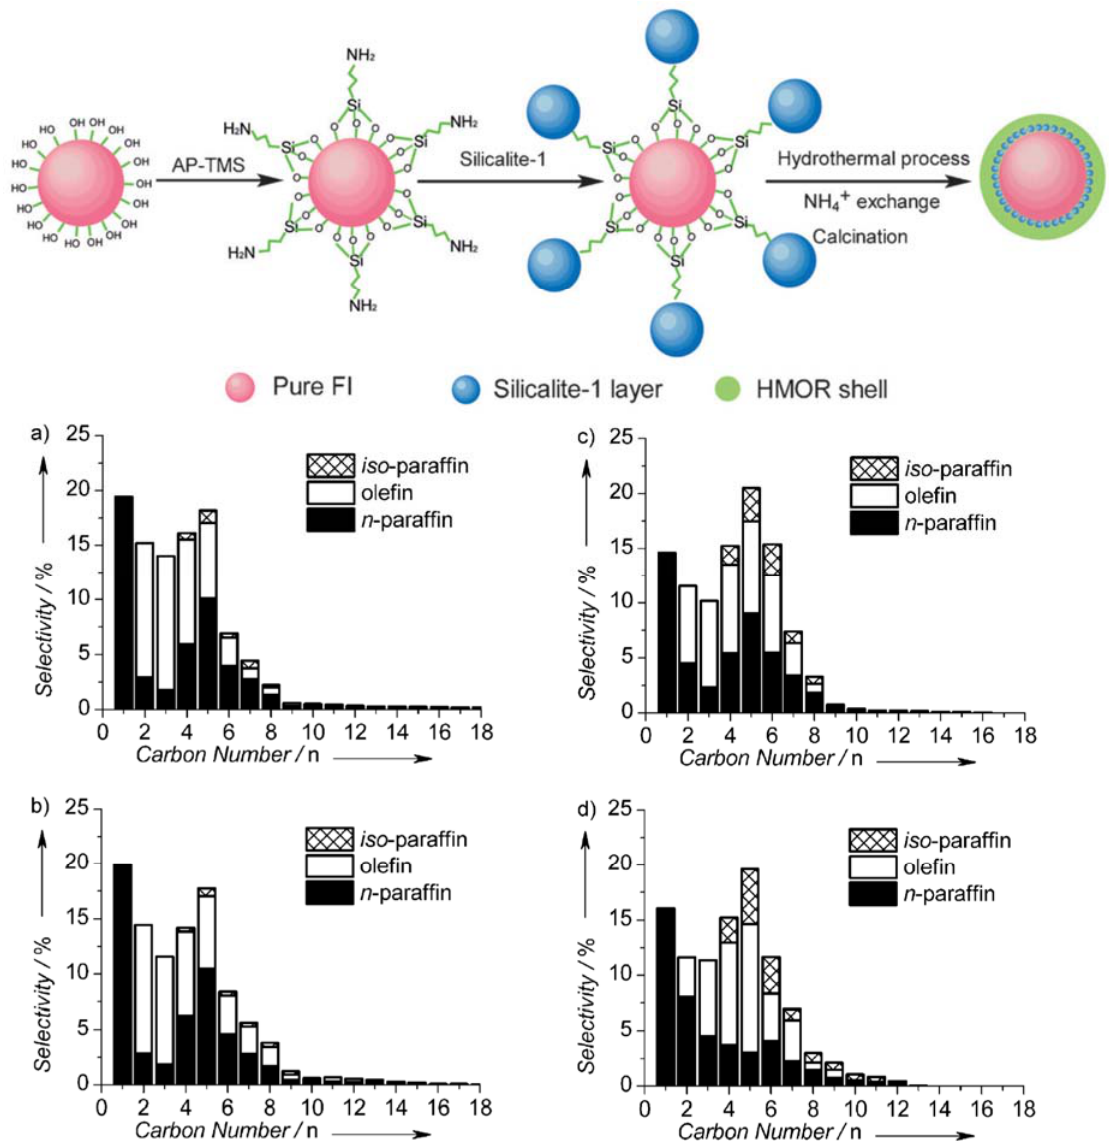
Figure 13. Scheme of the synthesis procedure of HMOR/FI capsule catalysts (FI = Fused Iron) without template and product distributions during Fischer-Tropsch synthesis (operating conditions: H 2 /CO = 1/1, 1.0 MPa, 300 °C, 10 g FI ·h − 1 ·mol − 1 ) obtained using ( a ) pure FI; ( b ) Silicalite-1/FI; ( c ) HMOR + FI; and ( d ) HMOR/FI. Reprinted with permission from [281]. Copyright (2013) John Wiley and